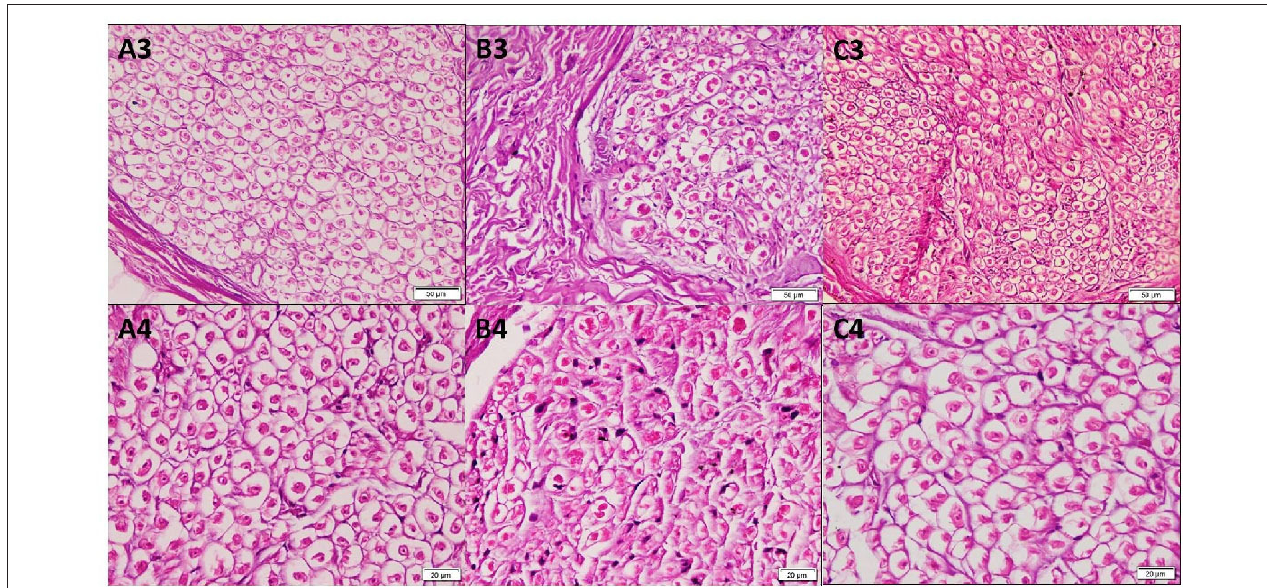
FIGURE 2 | Photomicrographs of transverse sections in cadaveric median nerve (H&E). Group A: (A3) nerve trunk from the arm (20); (A4) a higher magnification demonstrating many acidophilic axons surrounded by the neurolemmal sheath endoneurium (40). Group B: (B3) nerve trunk from the forearm (20); (B4) a higher